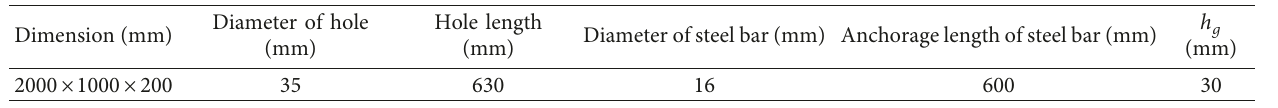
Figure 4: Ratios of the lateral dimension and depths of a 35mm hole. (a) l / d � 0.7. (b) l / d � 0.467. (c) l / d � 0.35. (d) l / d � 0.28. (e) l / d � 0.233. Table 1: Details of the